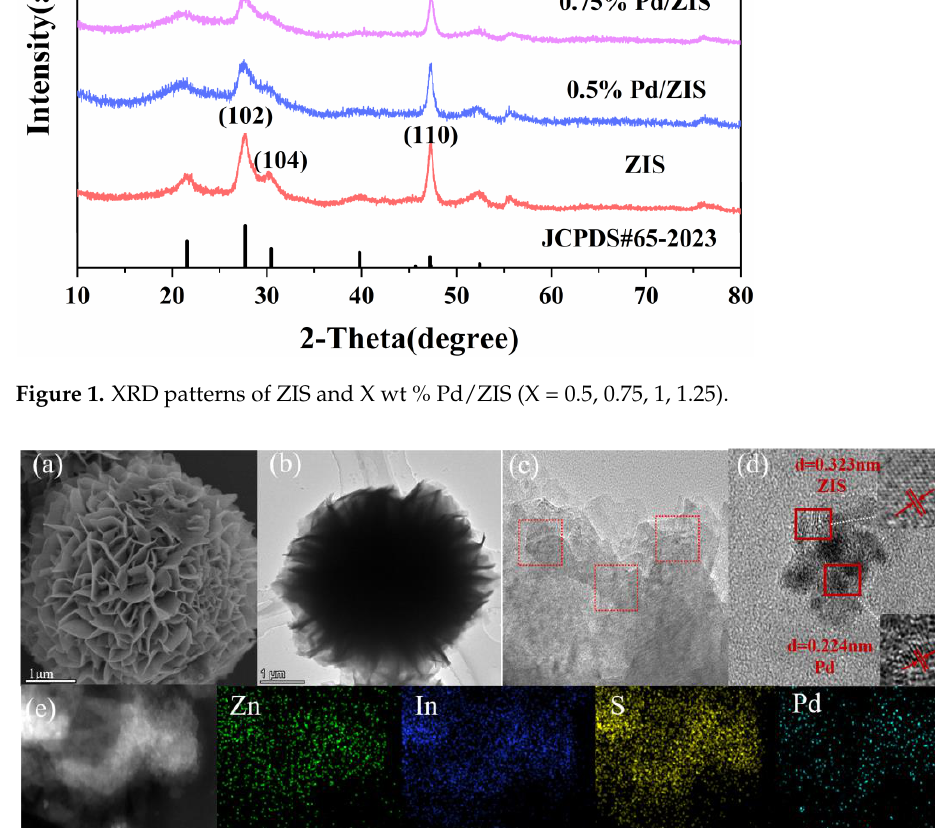
Figure 1. XRD patterns of ZIS and X wt % Pd/ZIS (X = 0.5, 0.75, 1, 1.25).